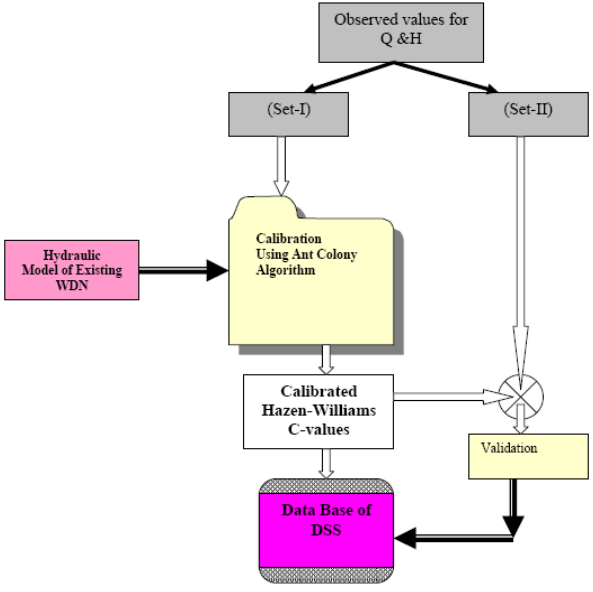
Figure 6. Schematic of simulation module of the Fig. 6. Schematic of Simulation module of the DSS Fig. 6. Schematic of Simulation module of the DSS